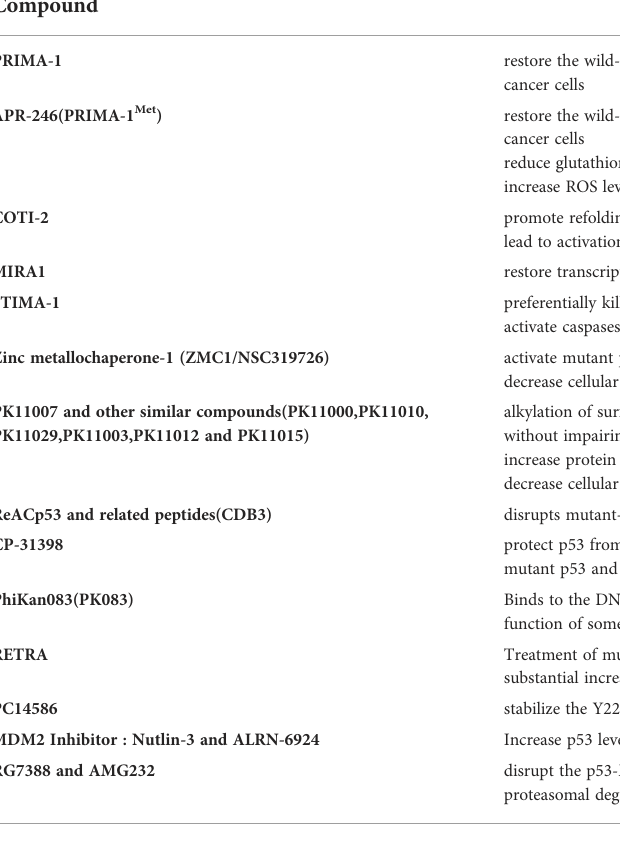
TABLE 1 Agents that target TP53